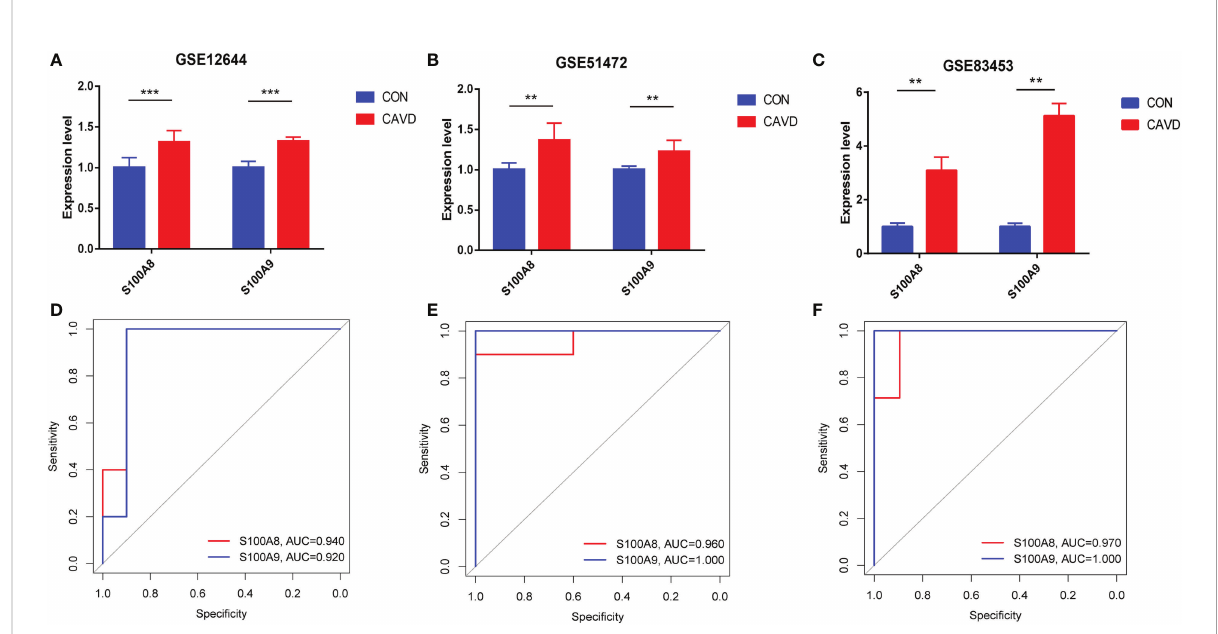
FIGURE 7 Diagnostic performance of S100A8/S100A9 expression levels for calci fi c aortic valve disease (CAVD) patients in the datasets. (A – C) The expression levels of S100A8 / S100A9 in CAVD were based on the GSE databases (GSE153555, GSE51472, and GSE83453). (D – F) Diagnostic value of S100A8 and S100A9 in GSE databases (GSE153555, GSE51472, and GSE83453). Receiver operating characteristic (ROC) curve of normal and CAVD valve tissues. ** P < 0.01, *** P < 0.001 when two groups were compared as indicated or compared with the corresponding